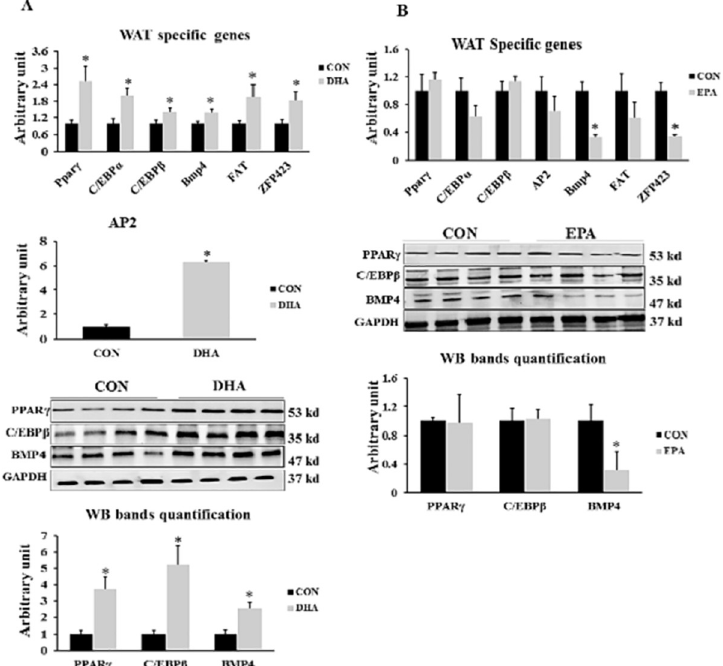
Fig 2. The effect of DHA and EPA on adipogenesis regulating genes. C2C12 cells were treated with white adipogenesis induction differentiation medium (WIDM) in the absence (CON) or presence of individual doses of 50 μ M EPA and 50 μ M DHA for 10 days. All the values of RT-qPCR are normalized to the expression levels of 18s genes and calculated in arbitrary units, n = 6. Data are represented as mean ± SEM. The significant difference is presented as � P < 0.05, Student’s t test. The level of GAPDH is used as a housekeeping gene to normalize the Western blots data. (A) Effect of DHA on the expression of WAT specific genes (B) Effect of EPA on the expression of WAT specific